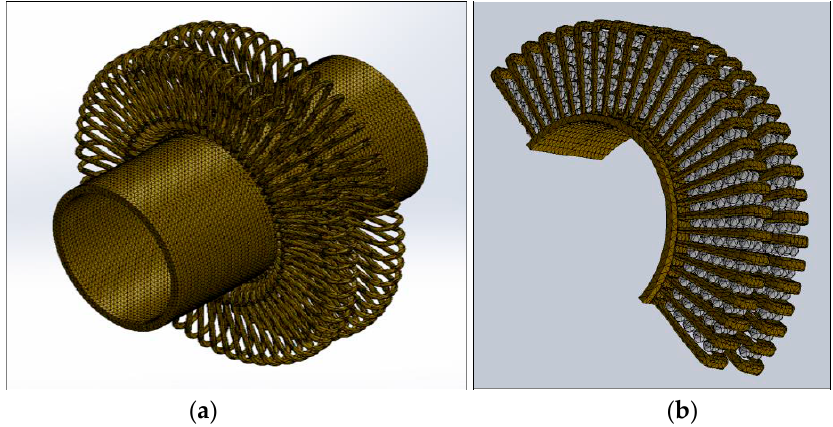
Figure 24. CFD representations showing a mesh detail of the wire woven fin pack with the adsorbent. ( a ) shows the CFD simulation meshes must have a sufficient number of points in the internal of the computational domain to describe the physical domain correctly; ( b ) shows an appropriate number of points need to be specified on the boundary conditions to characterise it accurately.